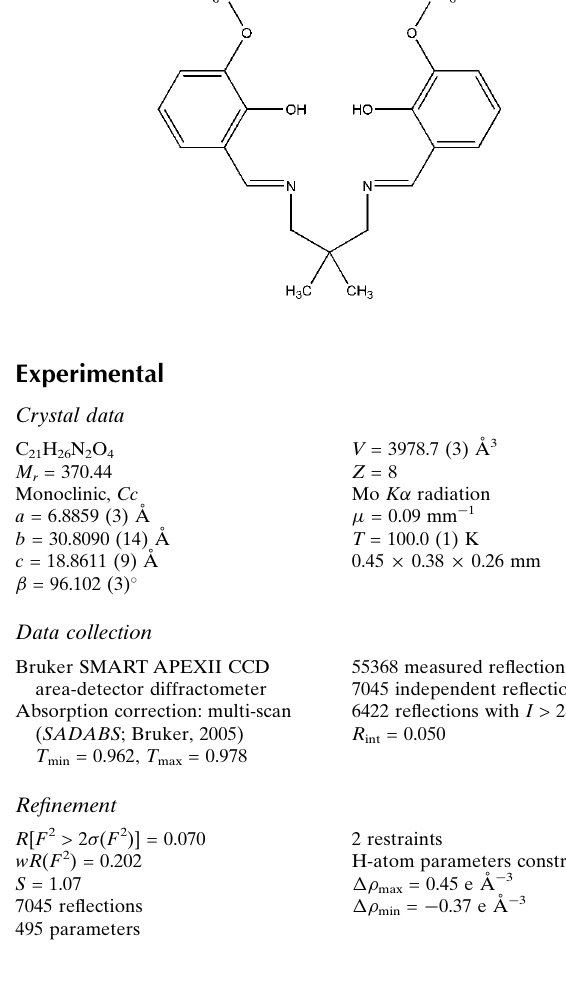
Selected geometric parameters (A˚ ) associated with (cid:2) – (cid:2) stacking interactions between the planar sections of C1 A –C6 A –C7 A –N1 A and